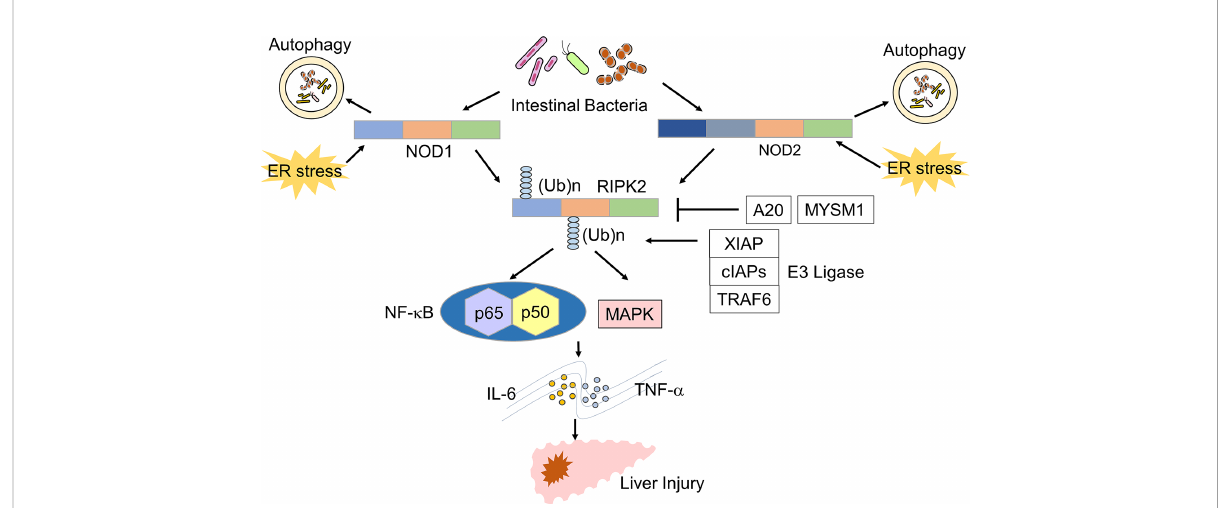
FIGURE 1 Signaling pathways of NOD1 and NOD2 leading to the development of liver injury. Nucleotide-binding oligomerization domain 1 (NOD1) and NOD2 detect muropeptides derived from the intestinal bacteria and endoplasmic reticulum (ER) stress. Activation of NOD1 and NOD2 leads to the polyubiquitination of receptor-interacting serine/threonine protein kinase 2 (RIPK2). Polyubiquitination of RIPK2 requires molecular interactions between RIPK2 and E3 ligases, including X-linked inhibitor of apoptosis (XIAP), cellular inhibitor of apoptosis proteins (cIAPs), and TNF-receptor associated factor 6 (TRAF6). A20 and MYSM1 remove polyubiquitin chains from RIPK2. Activation of RIPK2 induces the production of TNF- a and IL-6 through the nuclear translocation of NF- k B subunits and activation of the mitogen-activated protein kinase (MAPK) pathway and thereby promotes the development of liver